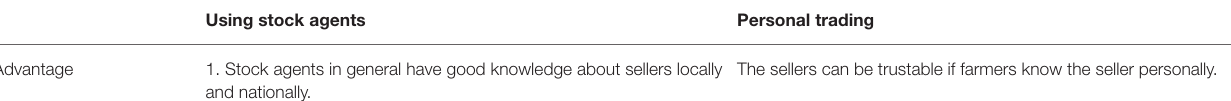
TABLE 4 | Advantage and disadvantage of identified methods to avoid shady farmers and associated farmers’